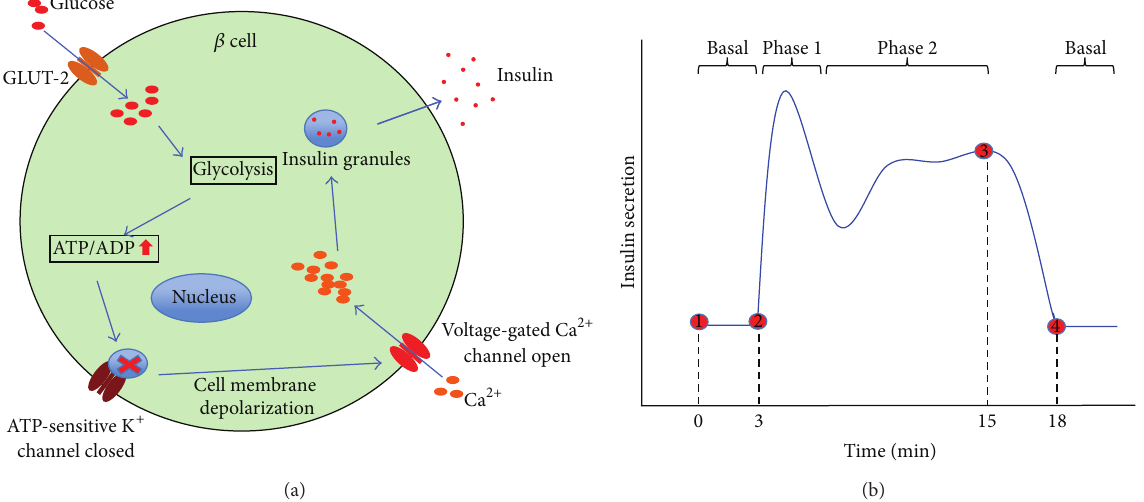
Figure 3: Diagram of insulin secretion from pancreatic 𝛽 cells. (a) Cellular representation of an insulin-release process; (b) Graphical display of the biphasic insulin